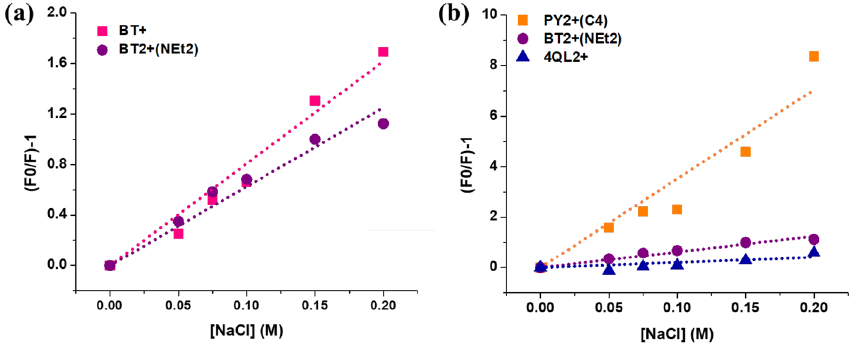
Figure 3. Quenching of the complexes of BT + and BT2 + (NEt 2 ) ( a ), PY2 + (C4) , BT2 + (NEt 2 ) , and 4QL2 + ( b ) (1 µM) with DNA (15 µM, in bp) in the presence of NaCl (50–200 mM).